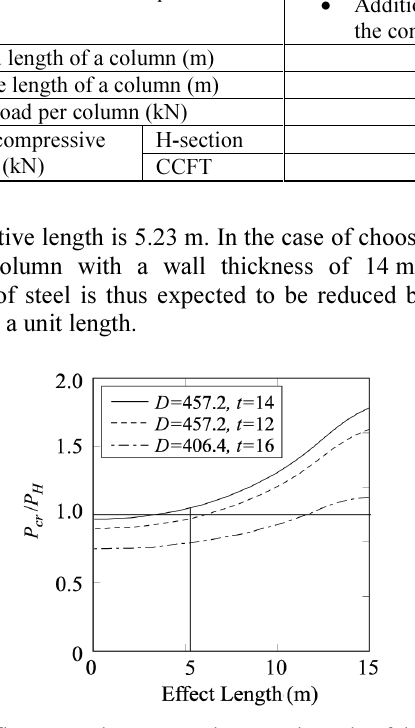
Fig. 6. Influence on the compressive capacity ratio of thickness and diameter